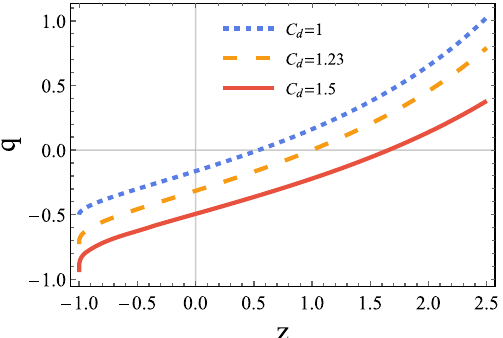
Fig. 3 Deceleration parameter q versus redshift z for three different values of C d , D d ,Δ = − 0 . 005, and d − Δ = 1. C d changes the value of q in z = − 1